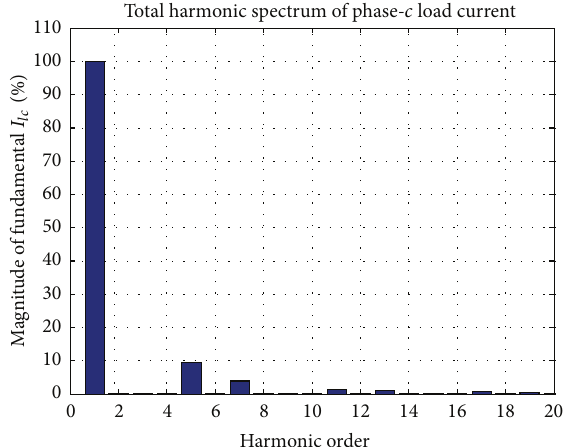
Figure 12: Frequency spectrum of phase- c load current.